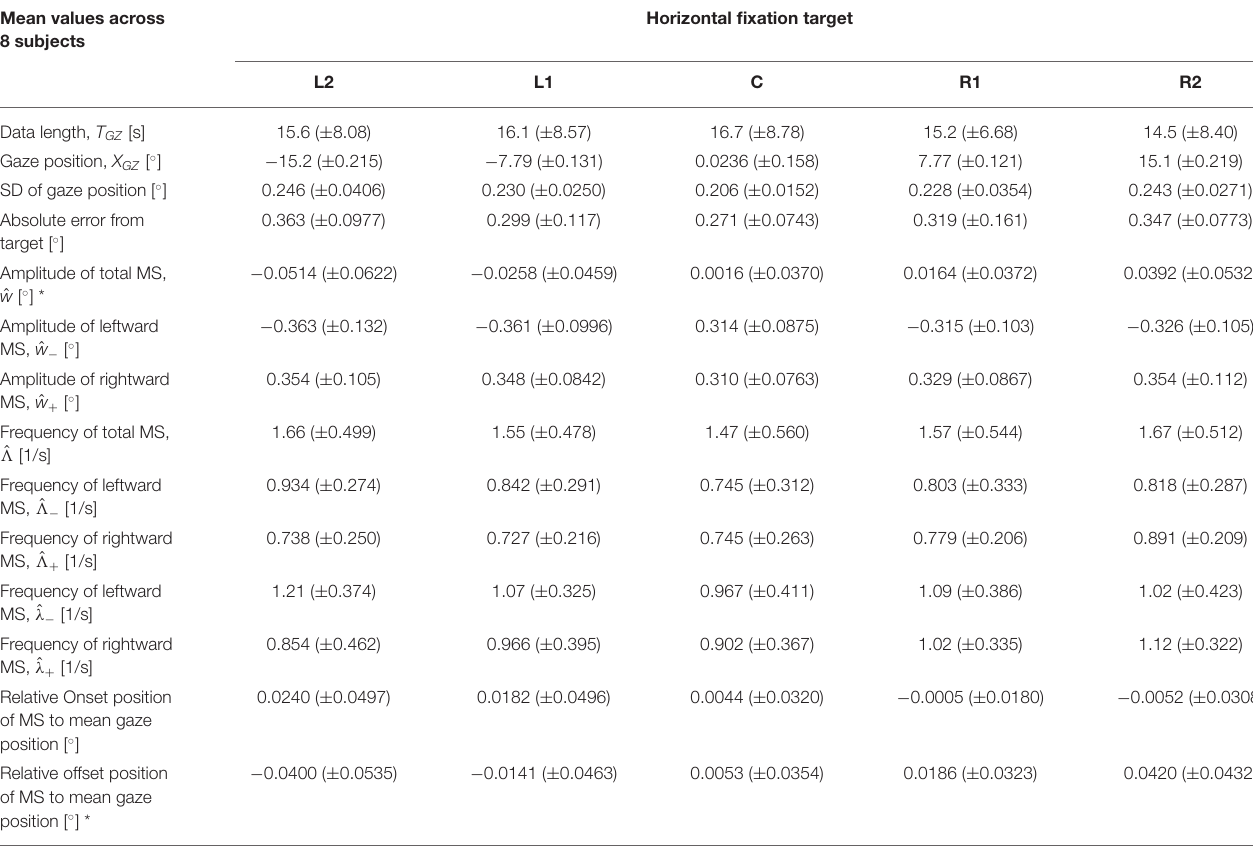
TABLE 1 | Dependence of horizontal gaze (GZ) position on the mean of each statistic for all subjects. Mean values across 8